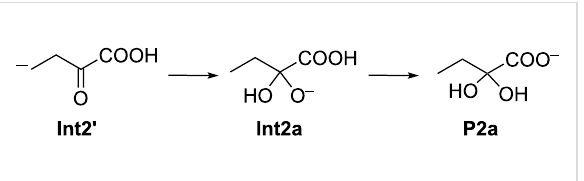
cated pathway involving a high-energy bicyclic intermediate Int4 was found (Figure